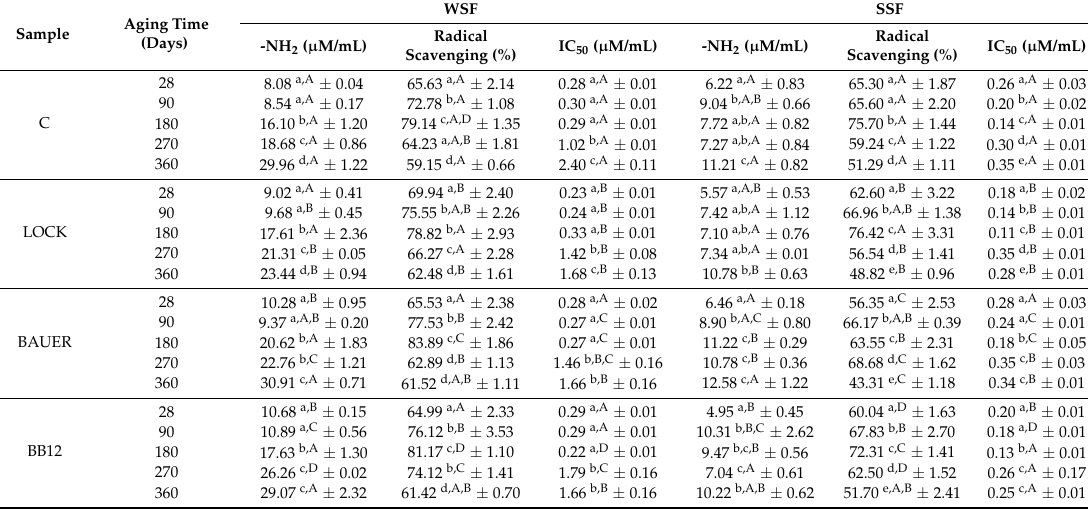
Table 2. Antiradical activity of protein extracts obtained from undigested dry-cured pork loins (mean ± standard